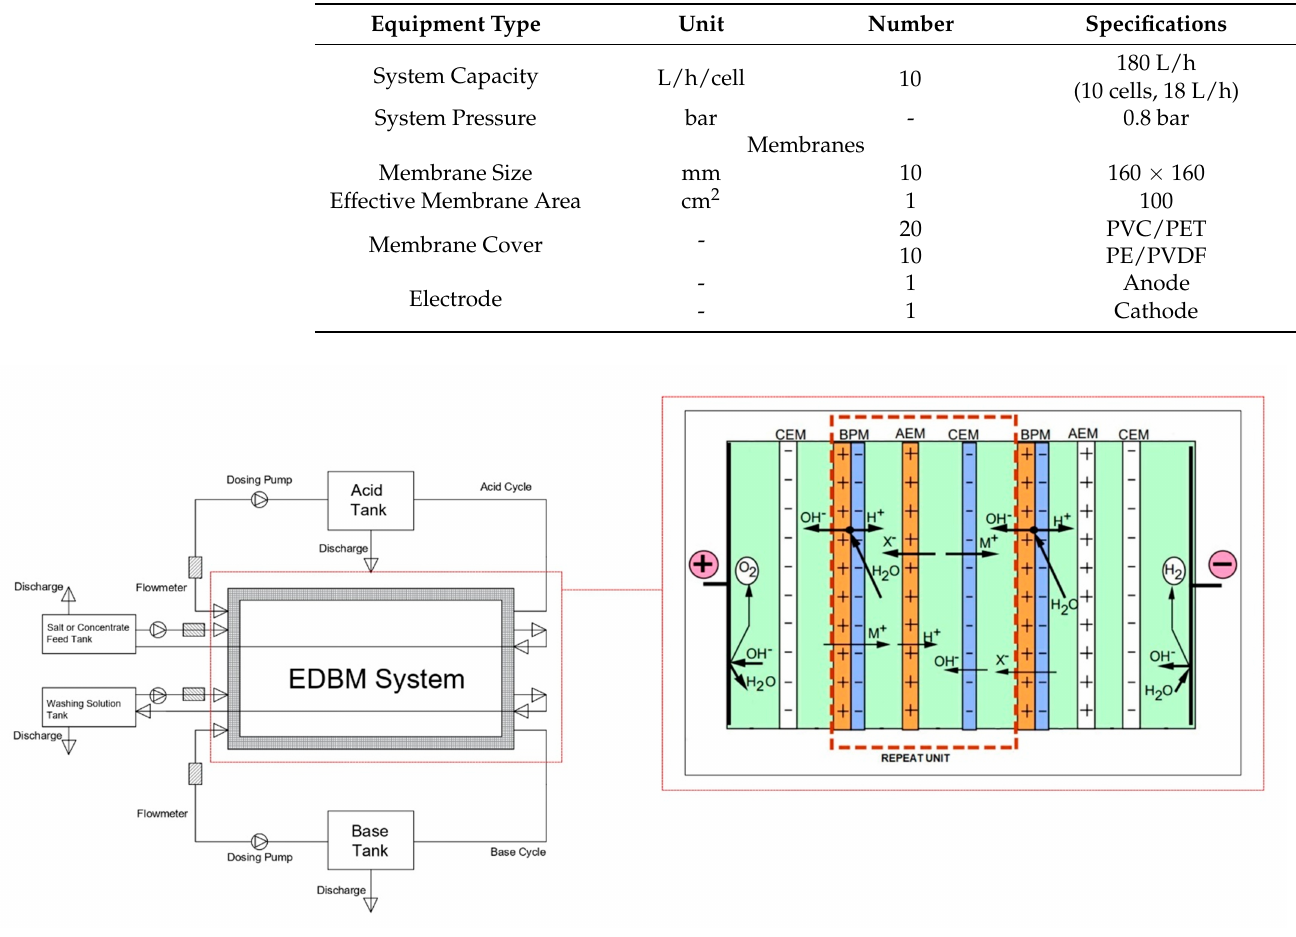
Table 2. Technical characteristics and specifications of the EDBM system.